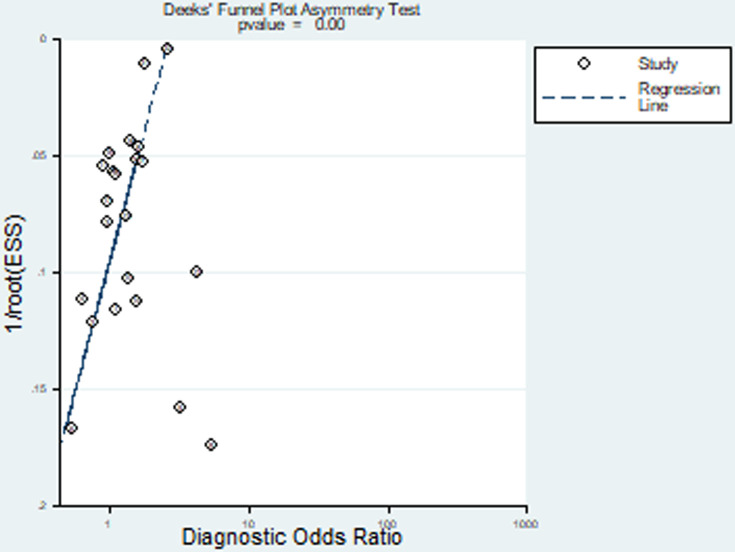
Publication bias.